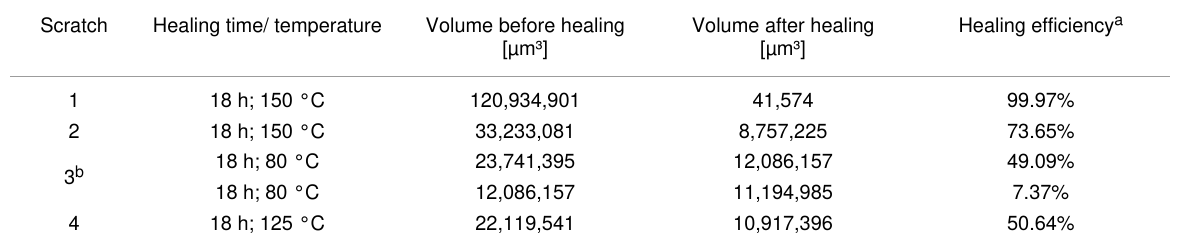
Table 1: Overview of the healing of P1 .